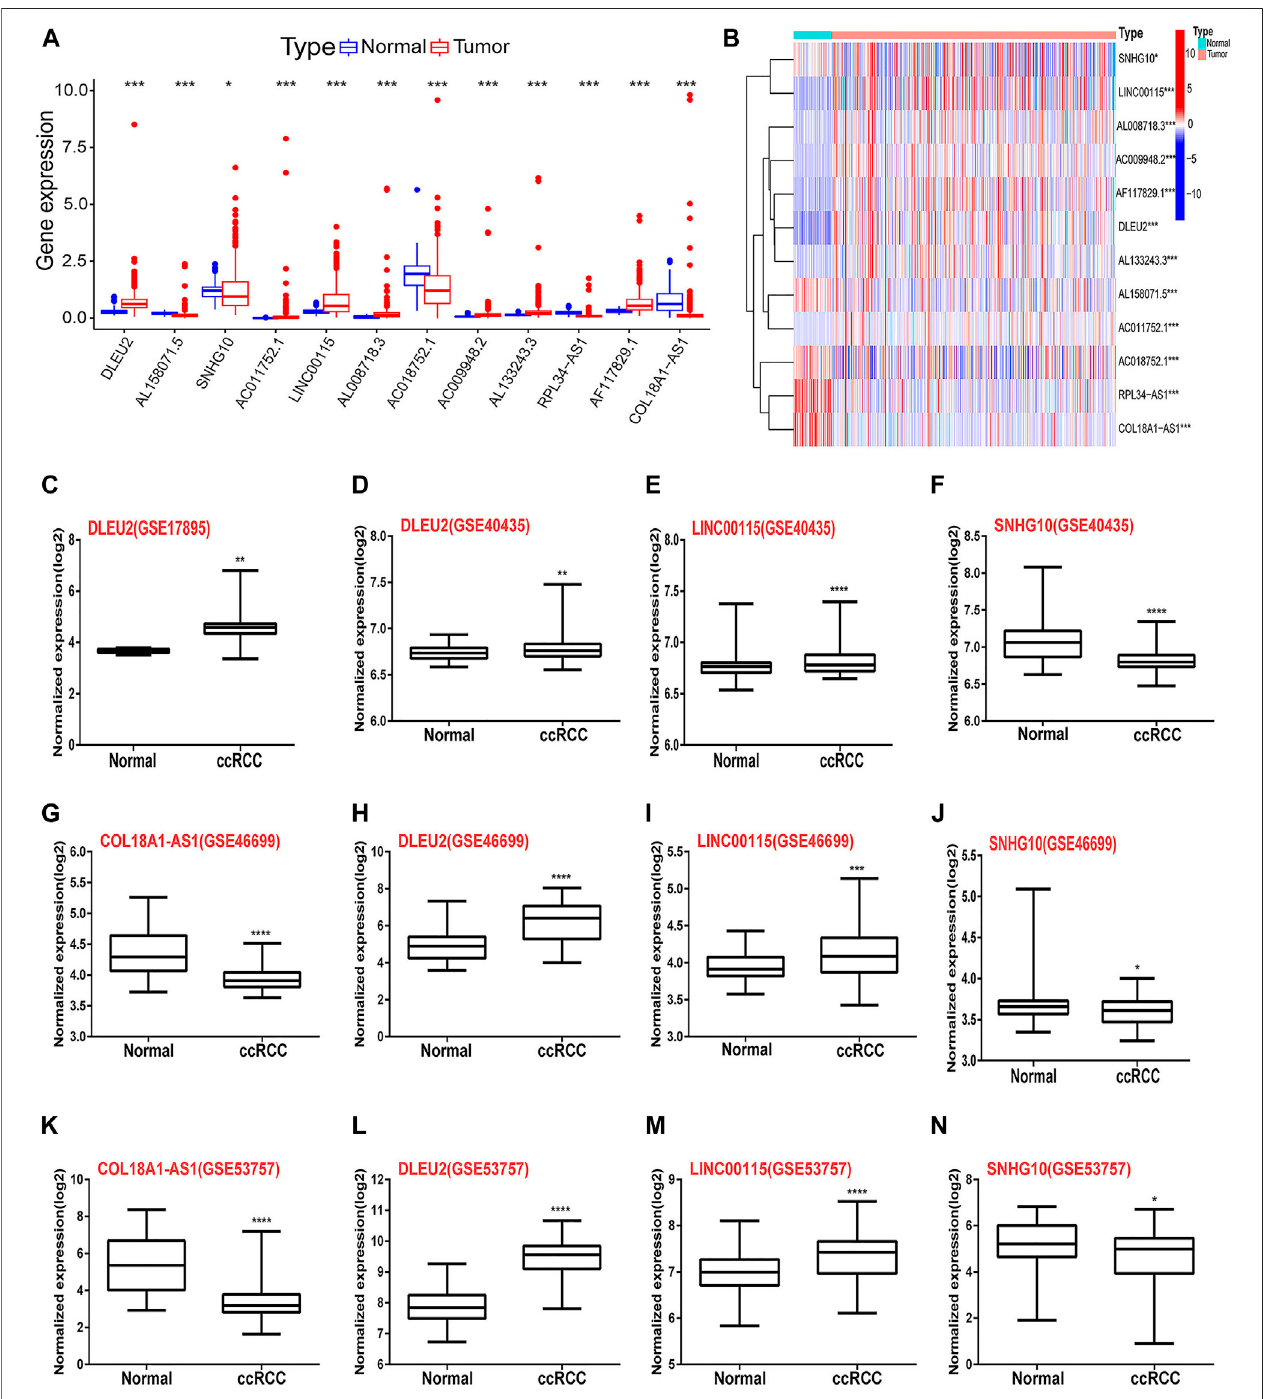
FIGURE6| Differentialexpressionofthe12m6A-RLsbetweentumorandnormalrenaltissues. (A) Boxplotsand (B) heatmapoftheexpressionofthe12m6A-RLs based on TCGA data. (C – N) Veri fi cation of the differential expression of several lncRNAs among the 12 m6A-RLs based on the GEO data. * p < 0.05; ** p < 0.01; *** p < 0.001, **** p <